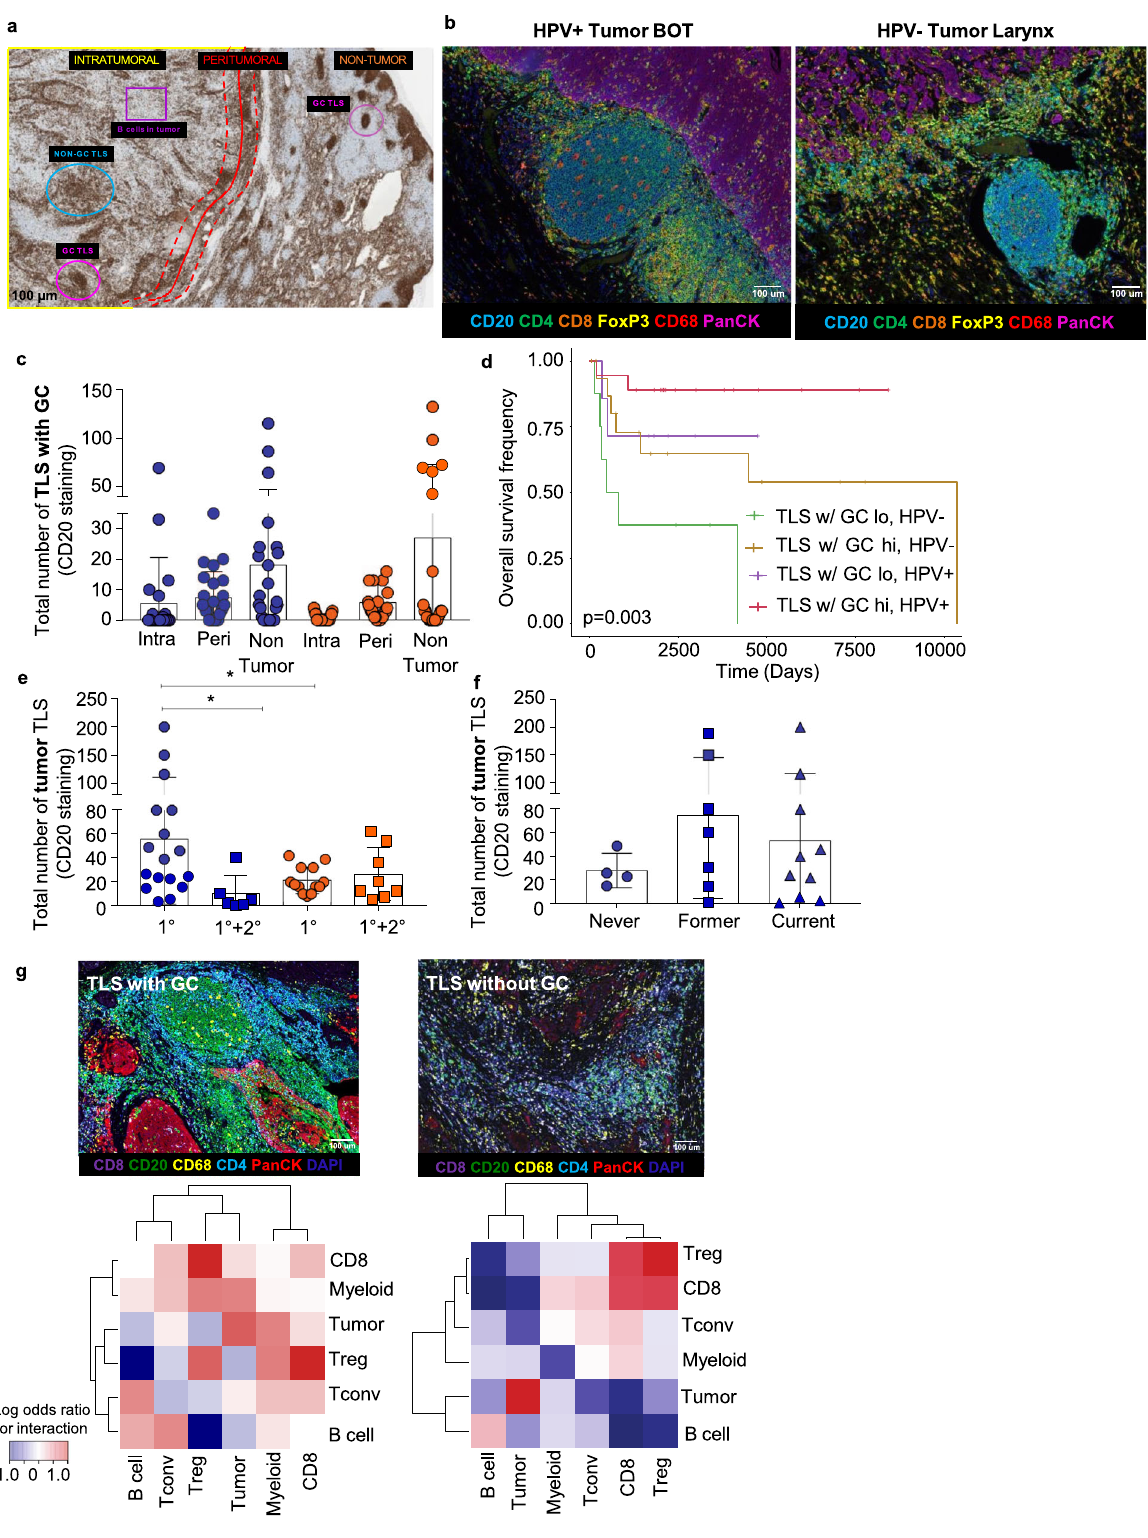
is associated with favorable antitumor immunity. Beyond cancer, our dissection of B cell biology can inform strategies aimed at enhancing vaccine responses, or conversely disrupting the gen- eration of B-cell mediated immune activation to suppress auto- immunity. Ultimately, this study highlights the signi fi cance of